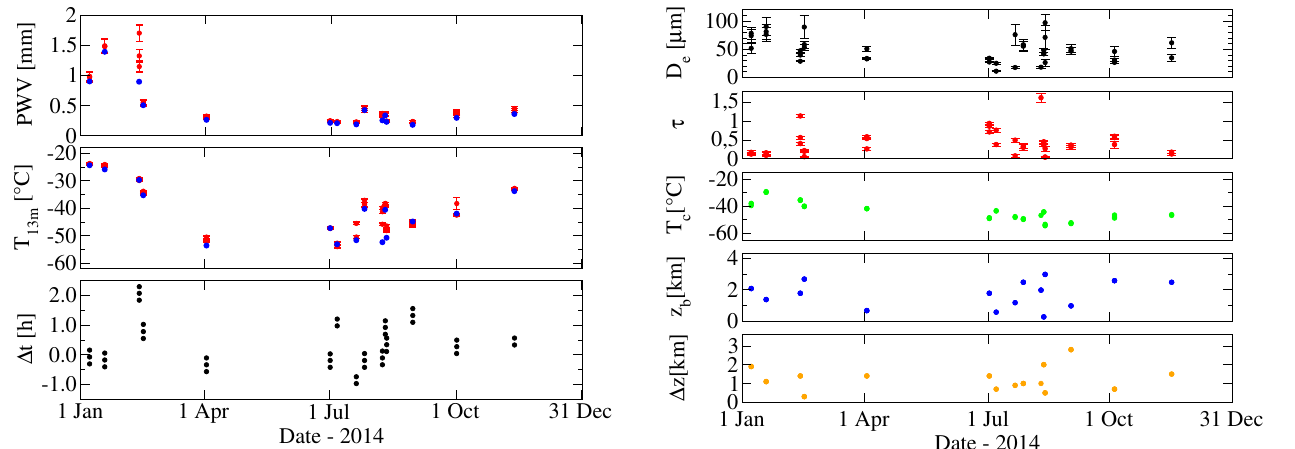
Figure 10. Comparison between the retrieved PWV and tempera- ture of the inversion layer at 13m above ground (red) with the cor- responding radiosonde values (blue). For each radiosonde value, the figure shows the comparison with the retrieval of the two/three near- est spectra. The bottom panel shows the time difference between the spectrum acquisition and the corresponding radiosonde launch.